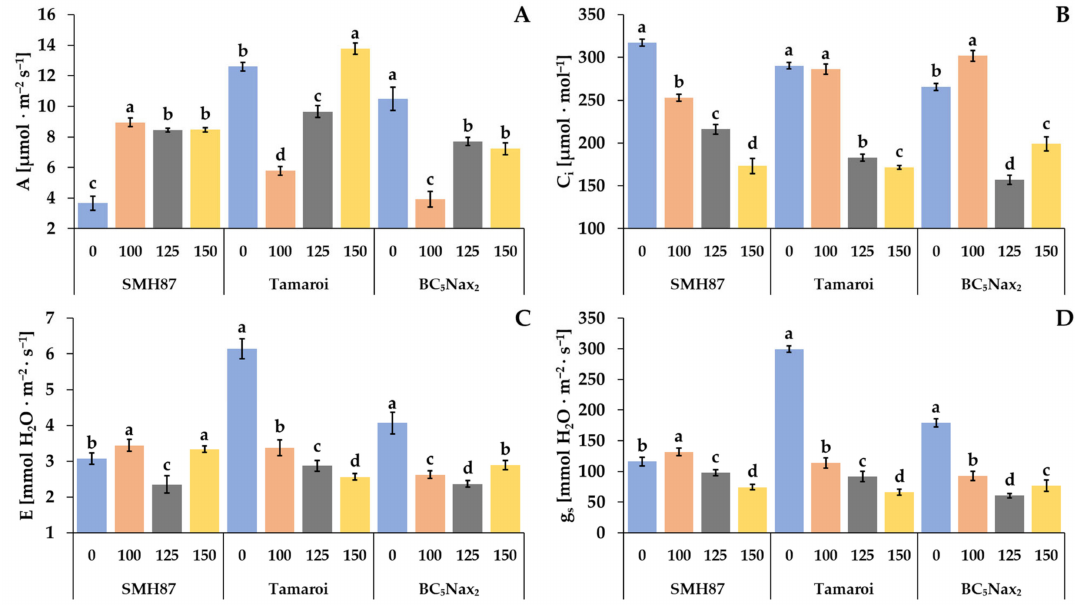
Figure 4. Effects of NaCl treatments (0, 100, 125, 150 mM) on the: A —net photosynthetic rate ( A ); C i —intercellular CO 2 concentration ( B ); E —transpiration rate ( C ), g s —stomatal conductance ( D ). The values represent means (n = 8) ± SE within each accession, and those marked with the same letters do not differ statistically according to multiple range Duncan’s test ( p <